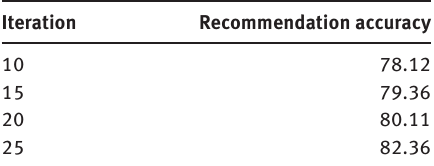
Table 3: Recommendation Accuracy Measures for Our Proposed Research. Iteration